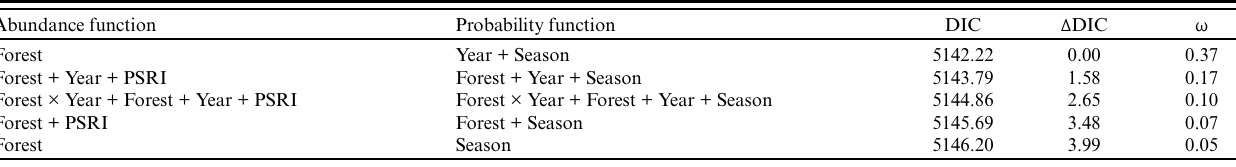
Table 2 . The five best-ranked Bayesian N-mixture CAR candidate models used to predict the abundance of Magellanic Woodpecker ( Campephilus magellanicus ). Covariates included in abundance model and probability functions are shown separately. Deviance’s information criterion (DIC), DIC difference with the lowest DIC model ( Δ DIC) and model weights ( ω ) are shown. Abundance function